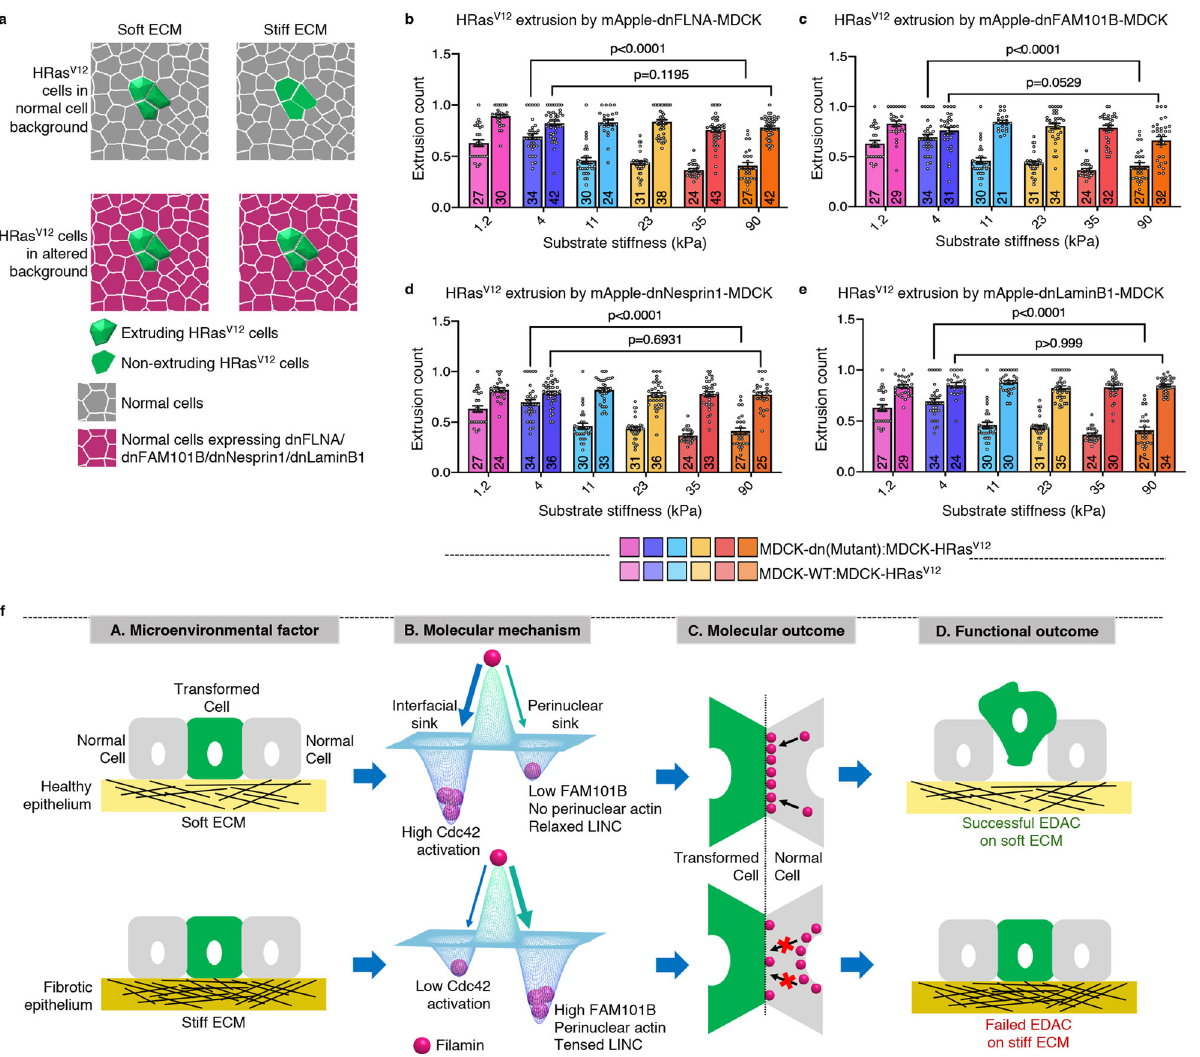
Fig. 5 Rescuing EDAC on stiff ECM. a An illustration showing the experimental design for rescuing EDAC on stiff ECM and the effect of different mosaic populations on extrusion of transformed cells on stiff ECM. b – e Scatter bar plots depicting the fraction of GFP-HRas V12 expressing colonies extruded over substrates of varying stiffness. For each stiffness, left bars are for mock MDCK-WT: MDCK-HRas V12 GFP and right bars are for mApple-dnFLNA- MDCK:MDCK-GFP-HRas V12 ( b ), MDCK-mApple-dnFAM101B:MDCK-GFP-HRas V12 ( c ), mApple-dnNesprin1-MDCK:MDCK-GFP-HRas V12 ( d ) or mApple- dnLaminB1-MDCK:MDCK-GFP-HRas V12 ( e ) mosaic populations. Stable expression of dnFLNA, dnFAM101B, dnNesprin1 or dnLaminB1 in surrounding cells rescued extrusion of transformed populations on the stiff substrate. The number of colonies counted is indicated inside each bar. Data are mean ± s.e.m. collected over three independent biological replicates. Statistical signi fi cance was assessed using Unpaired t -test with Welch ’ s correction (two-tailed). Signi fi cance value (when p < 0.0001) p = 9.27612e − 09. Source data ( b – e ) are provided as a Source Data fi le. f Summary of the integrative mechanism that connects the processes occurring at different length scales. We elucidate matrix mechanics, a microenvironmental factor ( a ), in fl uences the molecular dynamics of fi lamin ( b and c ) to determine the outcome of EDAC ( d